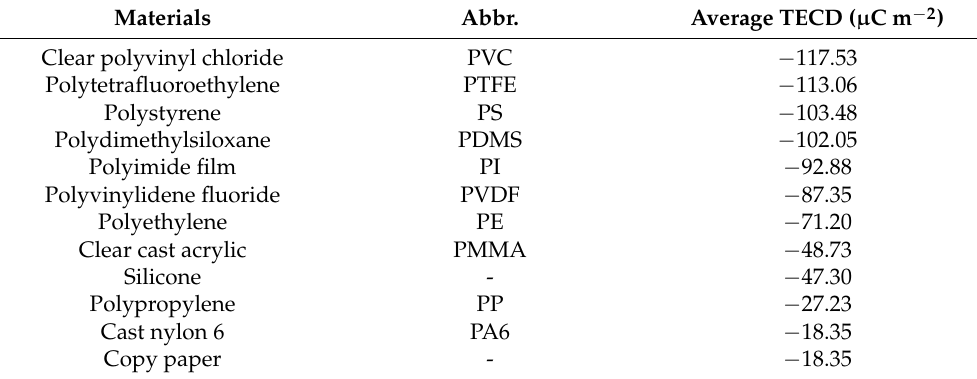
Table 1. Part of the triboelectric series of materials and their triboelectric charge density (TECD) (Reproduced with permission [70]. Copyright 2019 The